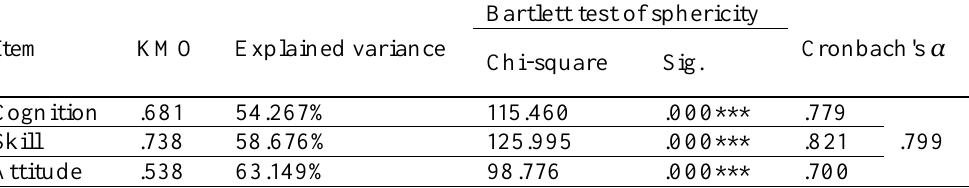
Validity of Self-Assessment Questionnaire